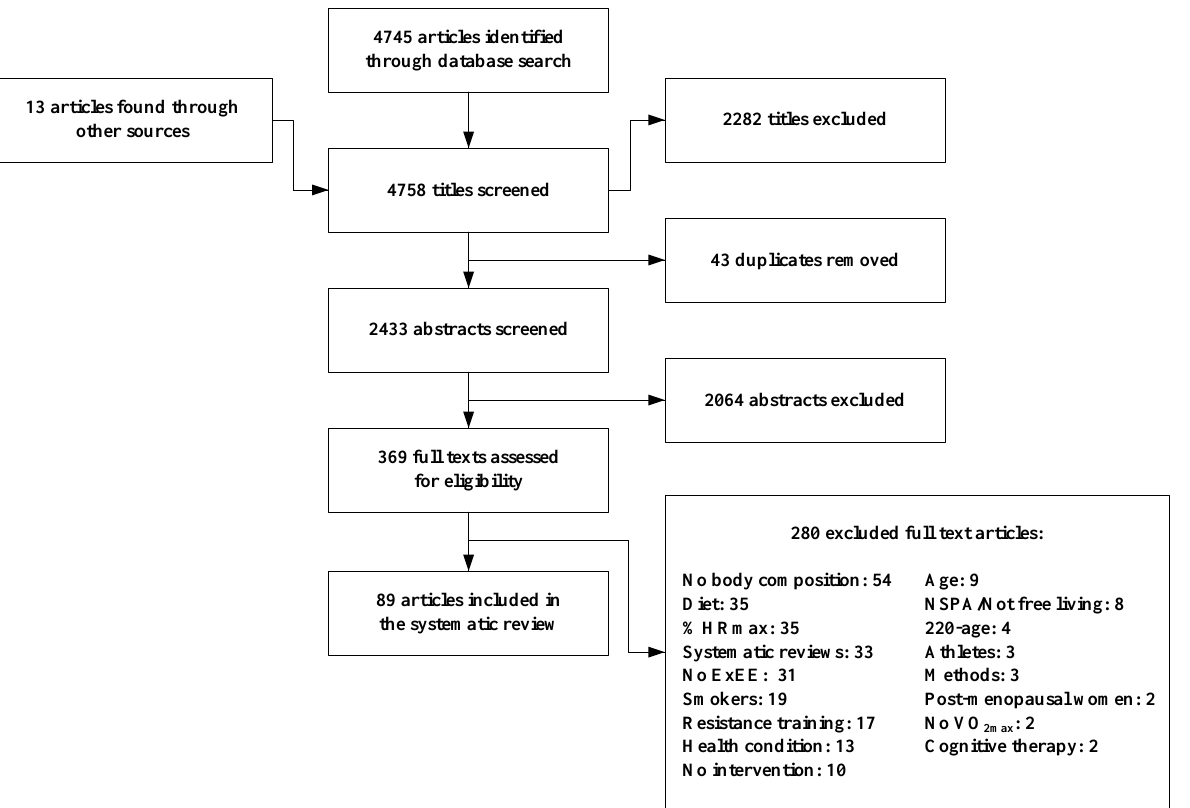
Figure 1. Flow diagram of the screening process. From the 89 studies selected, 71 were from original studies and 18 were from secondary data analyses of the 71 papers that were included. From the 71 studies, 61 groups were used in the final analysis. For these 61 groups, results were presented for each sex ( n = 26 male; n = 35 female), and body composition was measured with either dual-X-ray absorptiometry (DEXA), hydrostatic weighing or bod pod. Only articles with a mean age or with a small range of age ( i.e. , [19–23]) were kept for further investigation. One group was discarded because the frequency was not mentioned in the